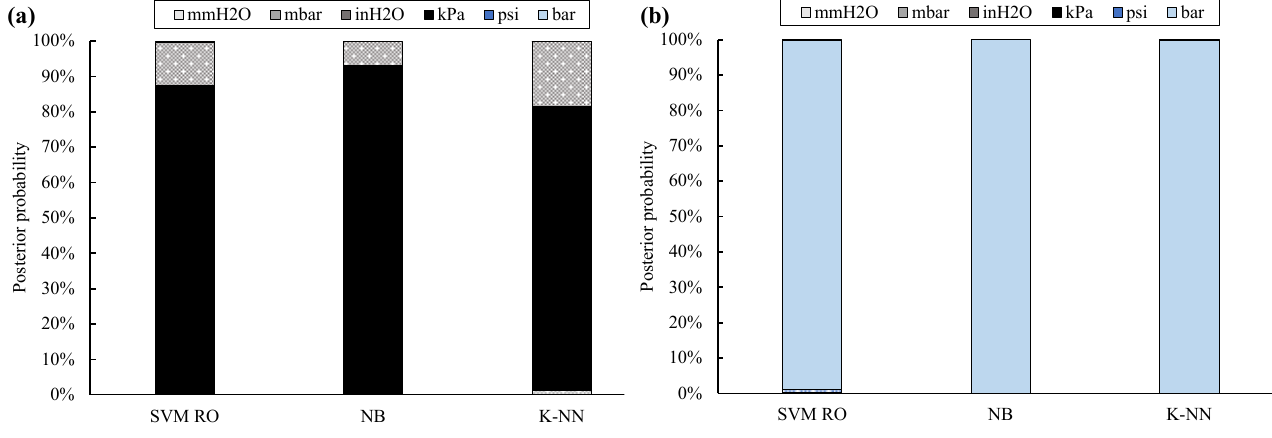
Figure 4. Posterior probability for twelve UOMs: training with 10 % of filtered data (full bar: absolute UOMs, dotted bar: gauge UOMs; kPa absolute sites ( a ), bar absolute site ( b )).